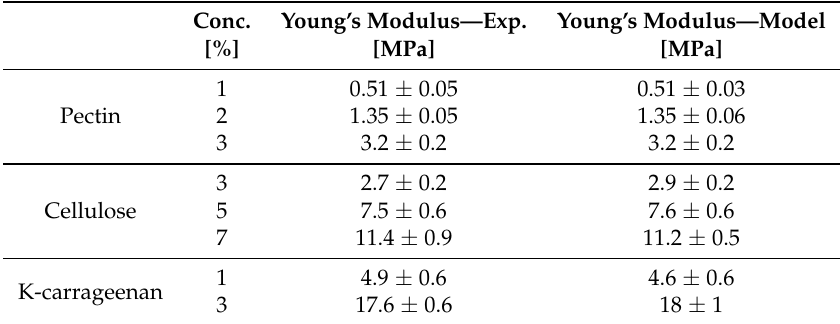
Table 3. Interpretation of Young’s modulus from the experimental and model stress-stretch curves in Figure